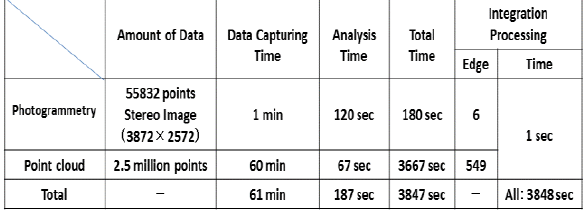
Table 2. Data acquisition and analysis